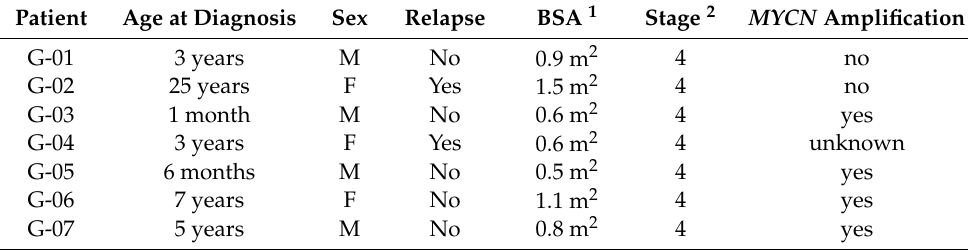
Table 1. Characteristics of patients enrolled in the compassionate-use treatment program.